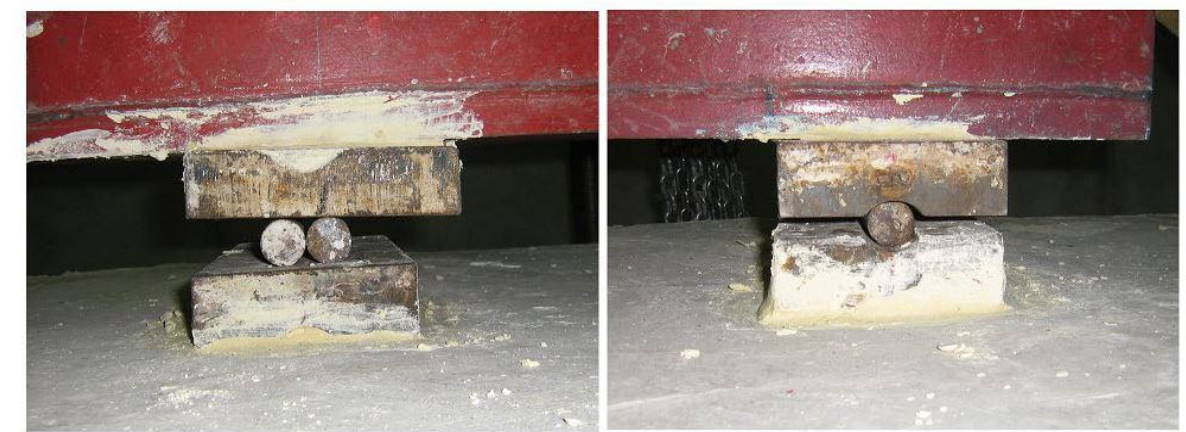
Figure 15. Load transmission beam